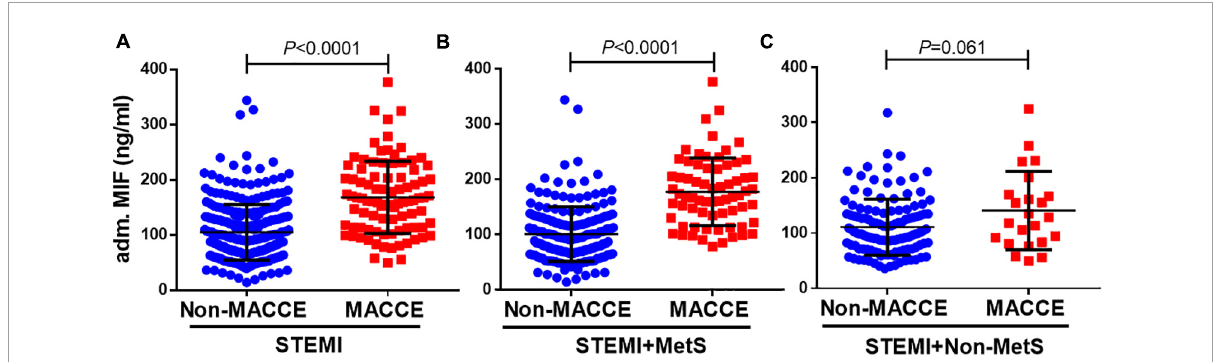
FIGURE2 Admission MIF levels between patients with MACCE and non-MACCE. Overall patients with STEMI [ (A) , non-MACCE, n = 309; MACCE, n = 92], STEMI + MetS [ (B) , non-MACCE, n = 186; MACCE, n = 69], and STEMI + non-MetS [ (C) , non-MACCE, n = 123; MACCE, n = 23]. MIF, macrophage migration inhibitory factor.